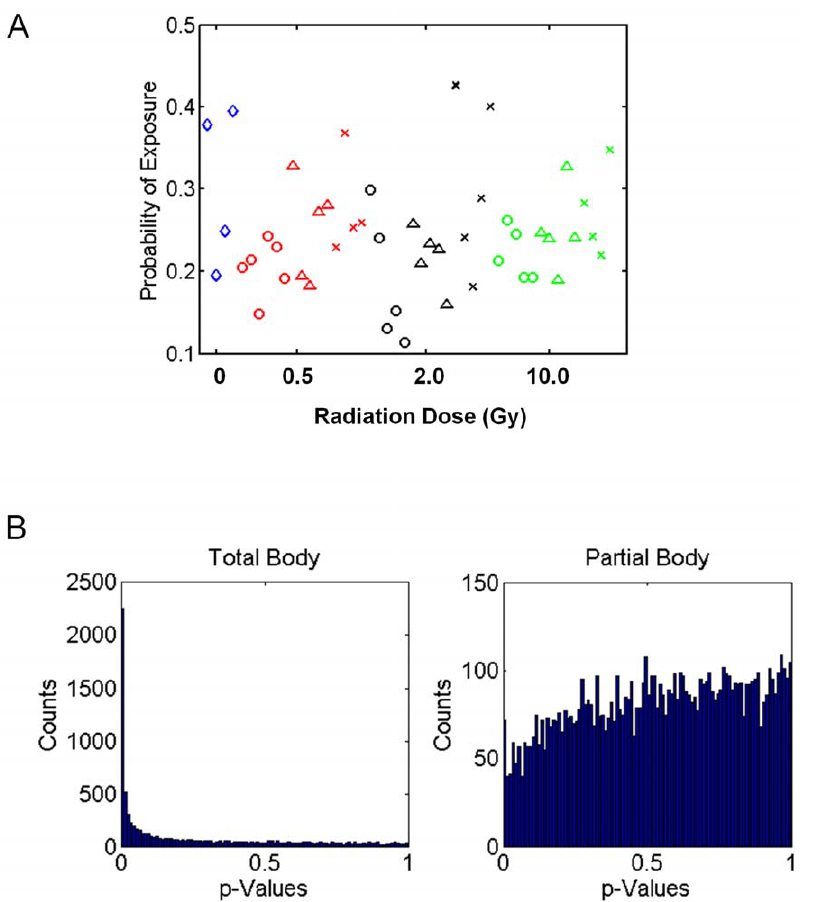
Figure 3. Prediction of radiation status of partially irradiated mice based upon the TBI gene expression profiles. (A) Diamonds represent control (non irradiated) samples, circles are exposure to AH, triangles are exposure to PH and Xs represent exposure to HL. Different dose levels were tested (blue=non-irradiated, red=0.5 Gy, black=2 Gy, green=10 Gy). The predictor built with the TBI samples shows no capacity to predict the radiation status of partially irradiated mice. (B) Histogram showing association of P values for association of genes with radiation exposure. A large increase in the number of small P values close to zero is observed compared to uniform distribution in the total body irradiation group (left). No trend is evident in P values in the partial body irradiated group of genes.